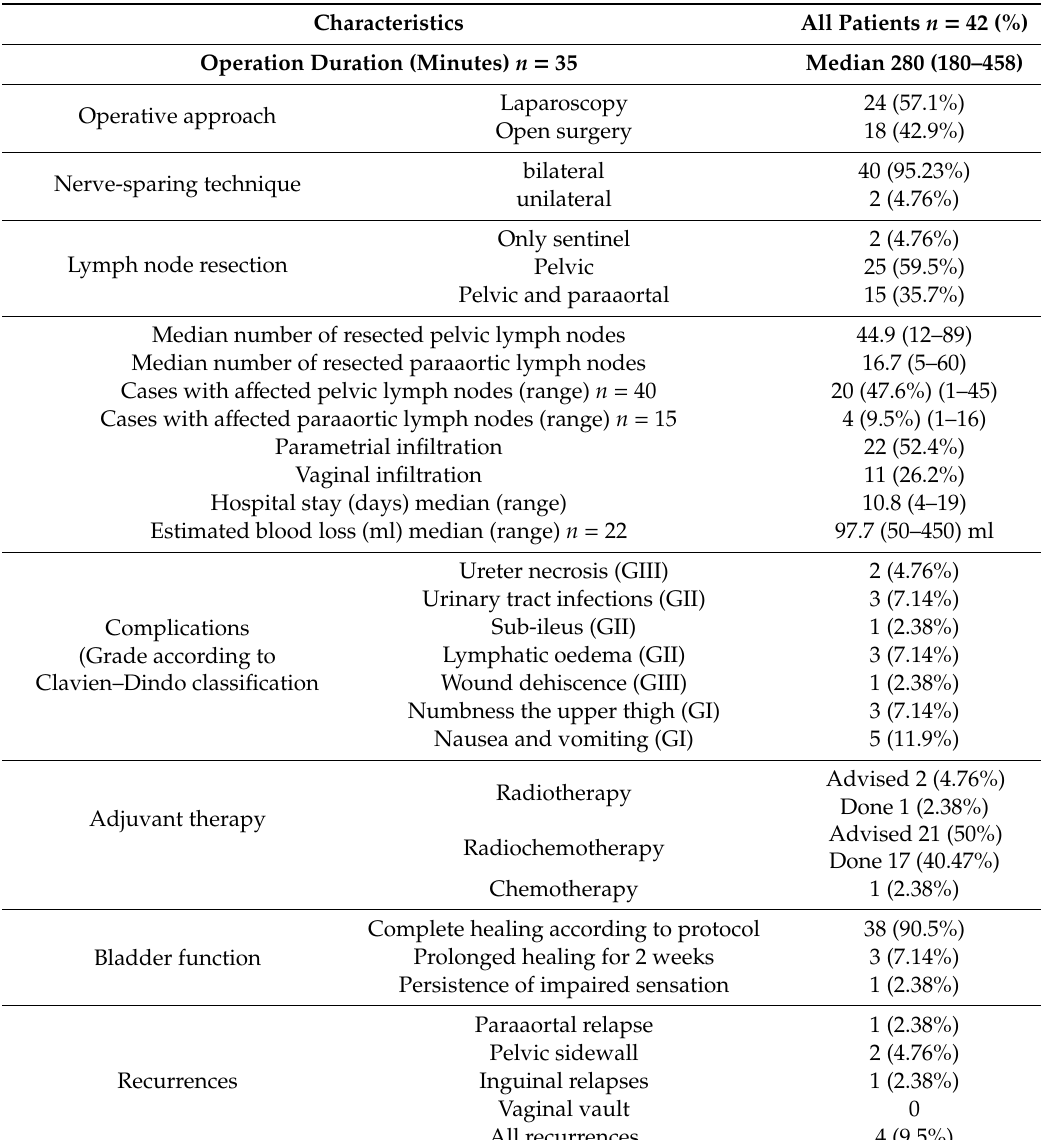
Table 2. Operation